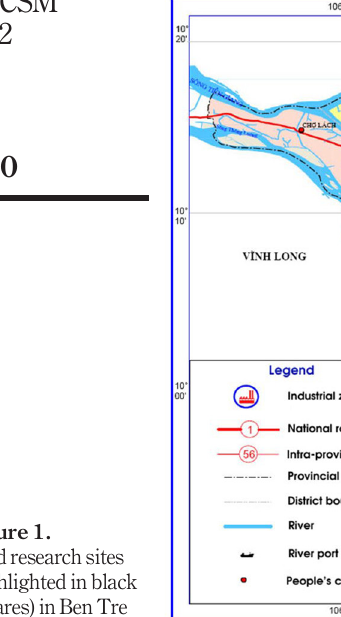
Figure 1. Field research sites (highlighted in black squares) in Ben Tre